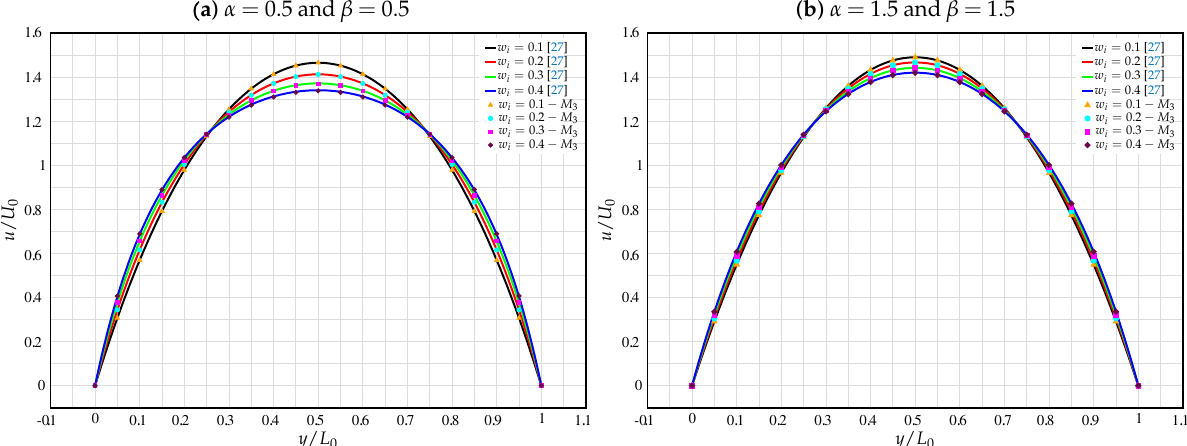
( b ) α = 1.5 and β = 1.5